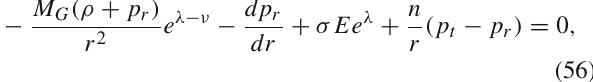
equilibrium of a class of relativistic stellar model in